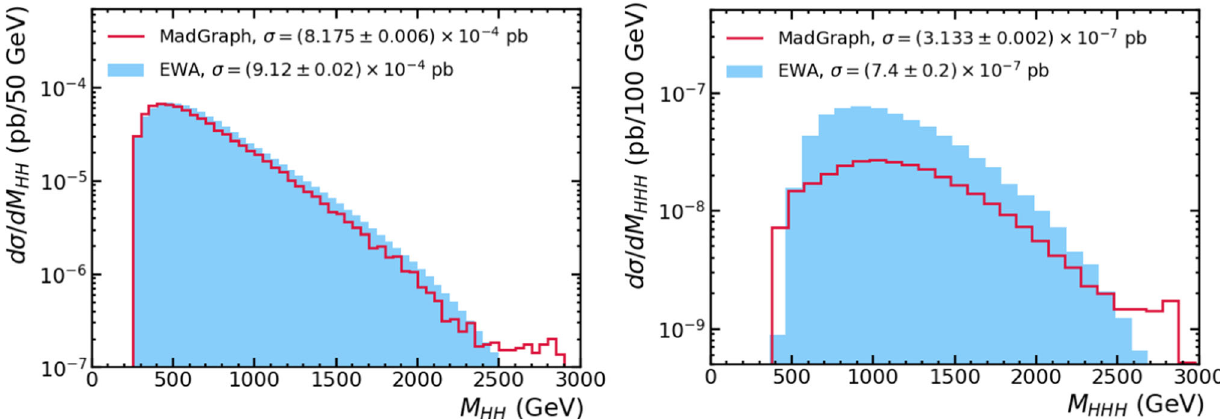
√ s = 3000 GeV with respect to the invariant mass